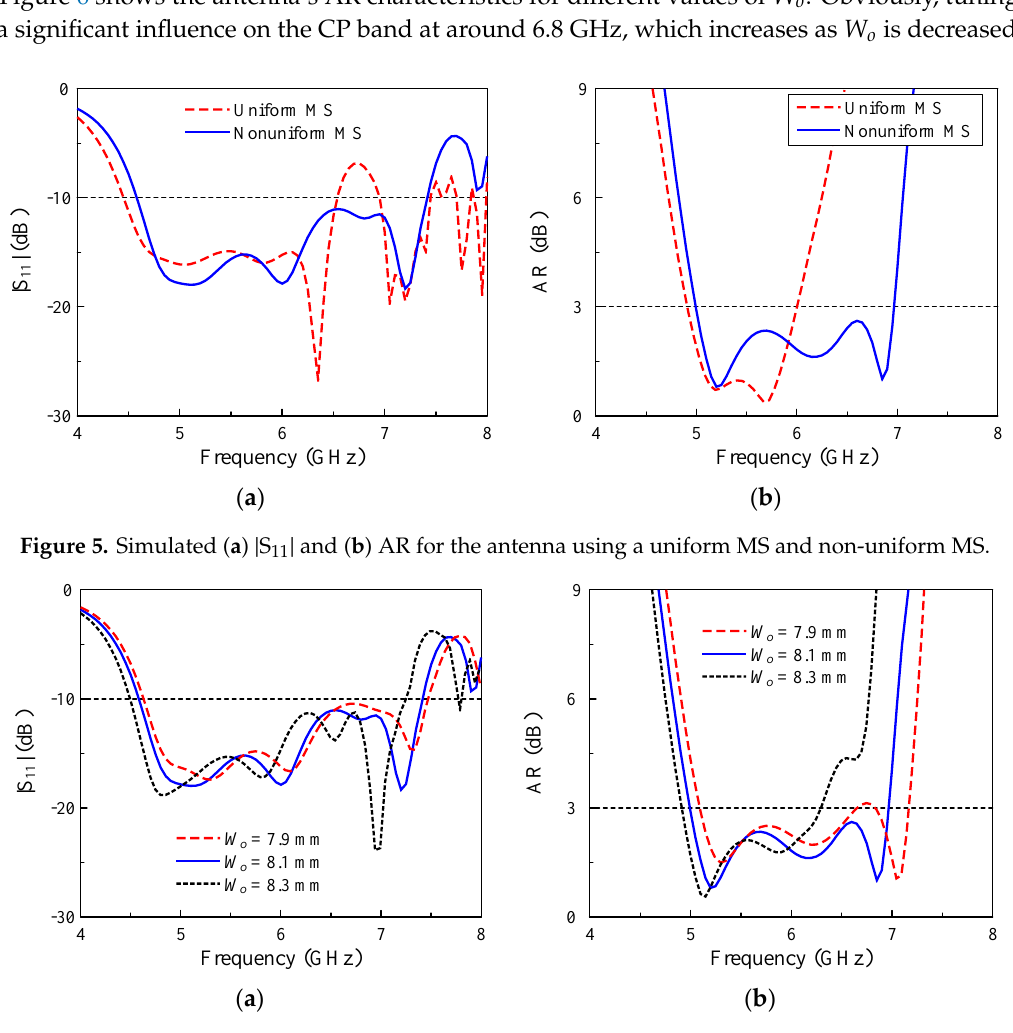
Figure 6. Simulated ( a ) |S 11 | and ( b ) AR of the non-uniform based antenna with different sizes of the outer unit cell, W o .